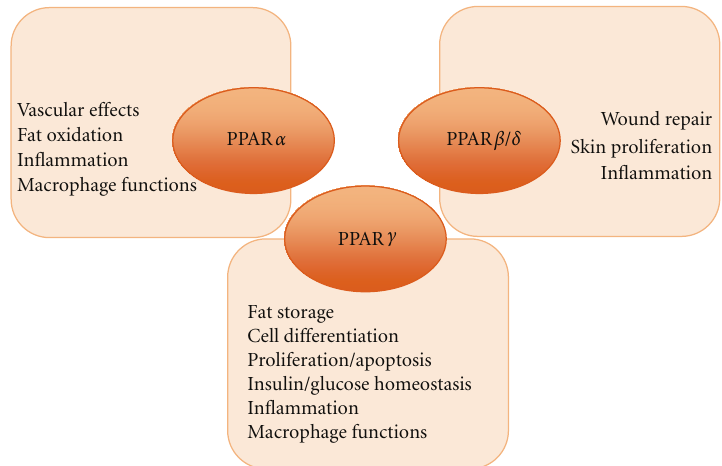
Figure 1: Overview of PPARs physiological roles.